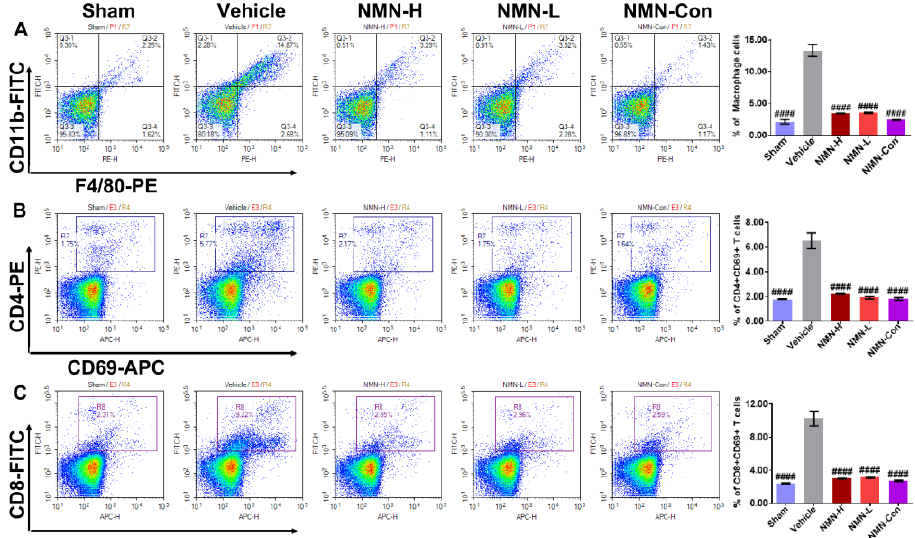
Figure 4. NMN intervention for 7 days decreases the proportion of macrophages, CD4 + CD69 + T cells, and CD8 + CD69 + T cells in silica-induced lung injury. ( A ) Proportions of macrophages in lung tissue; ( B ) proportions of CD4 + CD69 + T cells in lung tissue; ( C ) proportions of CD8 + CD69 + T cells in lung tissue. ## indicates p < 0.01, ### p < 0.001, #### p < 0.0001 vs. Vehicle). Sham: saline + saline; Vehicle: silica + saline; NMN-H: silica + NMN (1000 mg/kg); NMN-L: silica + NMN (500 mg/kg); NMN-Con: saline + NMN (1000 mg/kg).